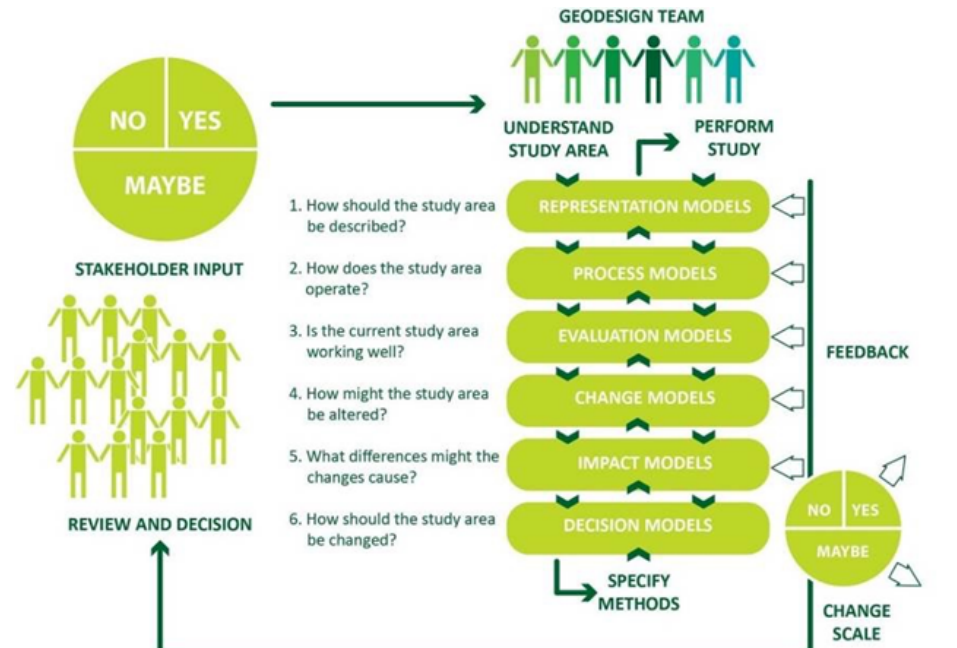
Figure 2. The structure of the geodesign framework of Steinitz (2012). Graphics by REPAiR researcher Libera Amenta. with: (1) the basic concepts used during the course—CE, geodesign, EIS; (2) the case study area—the AMA; (3) the